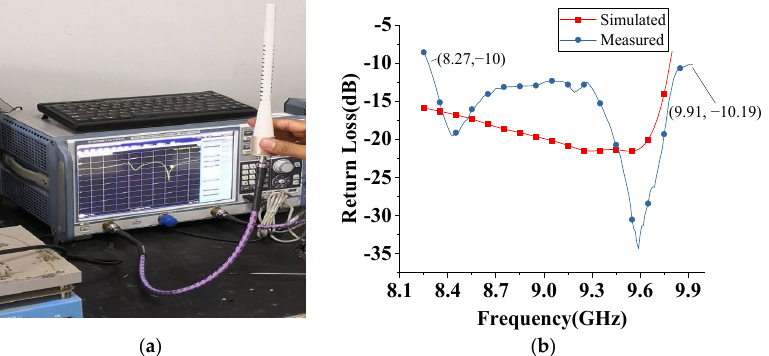
Figure 12. ( a ) Return Loss measurement setup ( b ) Simulated and measured return loss of Embedded Helix and DR antenna.